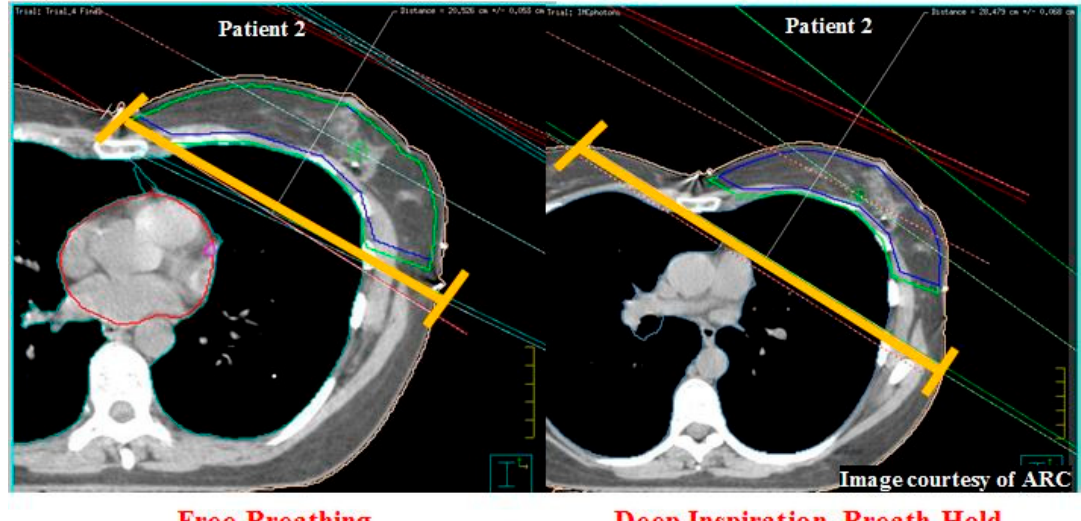
Figure 4. Demonstration of chest wall separation (CWS) (yellow) increasing from 28.4 cm in the FB plan (left) to 20.4 cm the DIBH plan (right) for patient 2 (multileaf collimator placement omitted). The heart (red), clinical target volume (blue) and planning target volume (green) are also demonstrated (Image Courtesy of ARC).